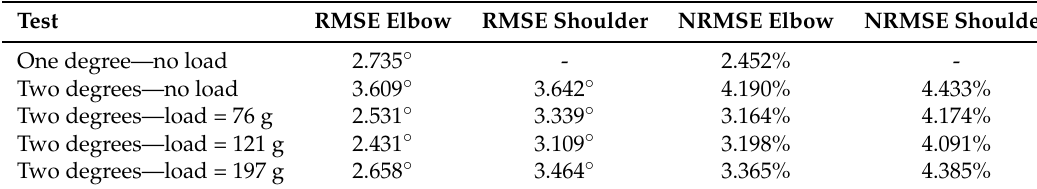
Table 2. Error obtained in the three experiments.